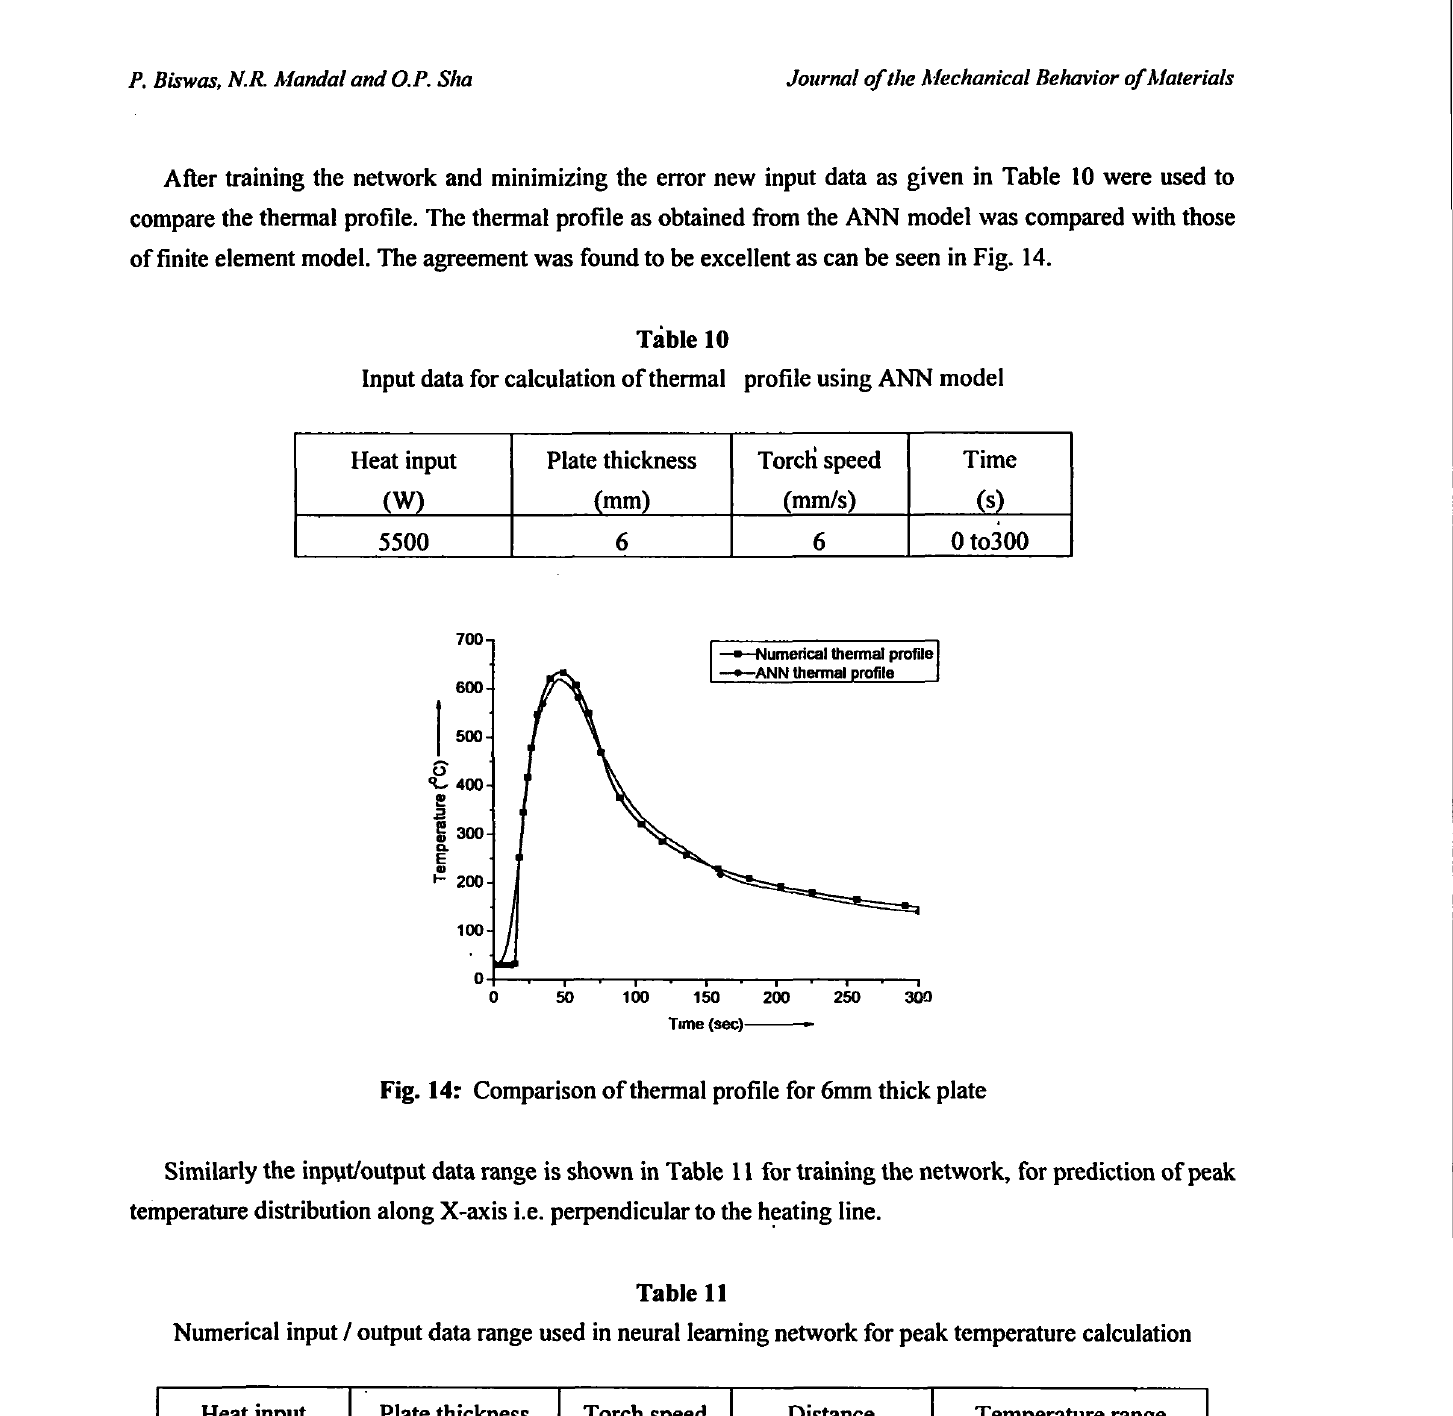
Fig. 14: Comparison of thermal profile for 6mm thick